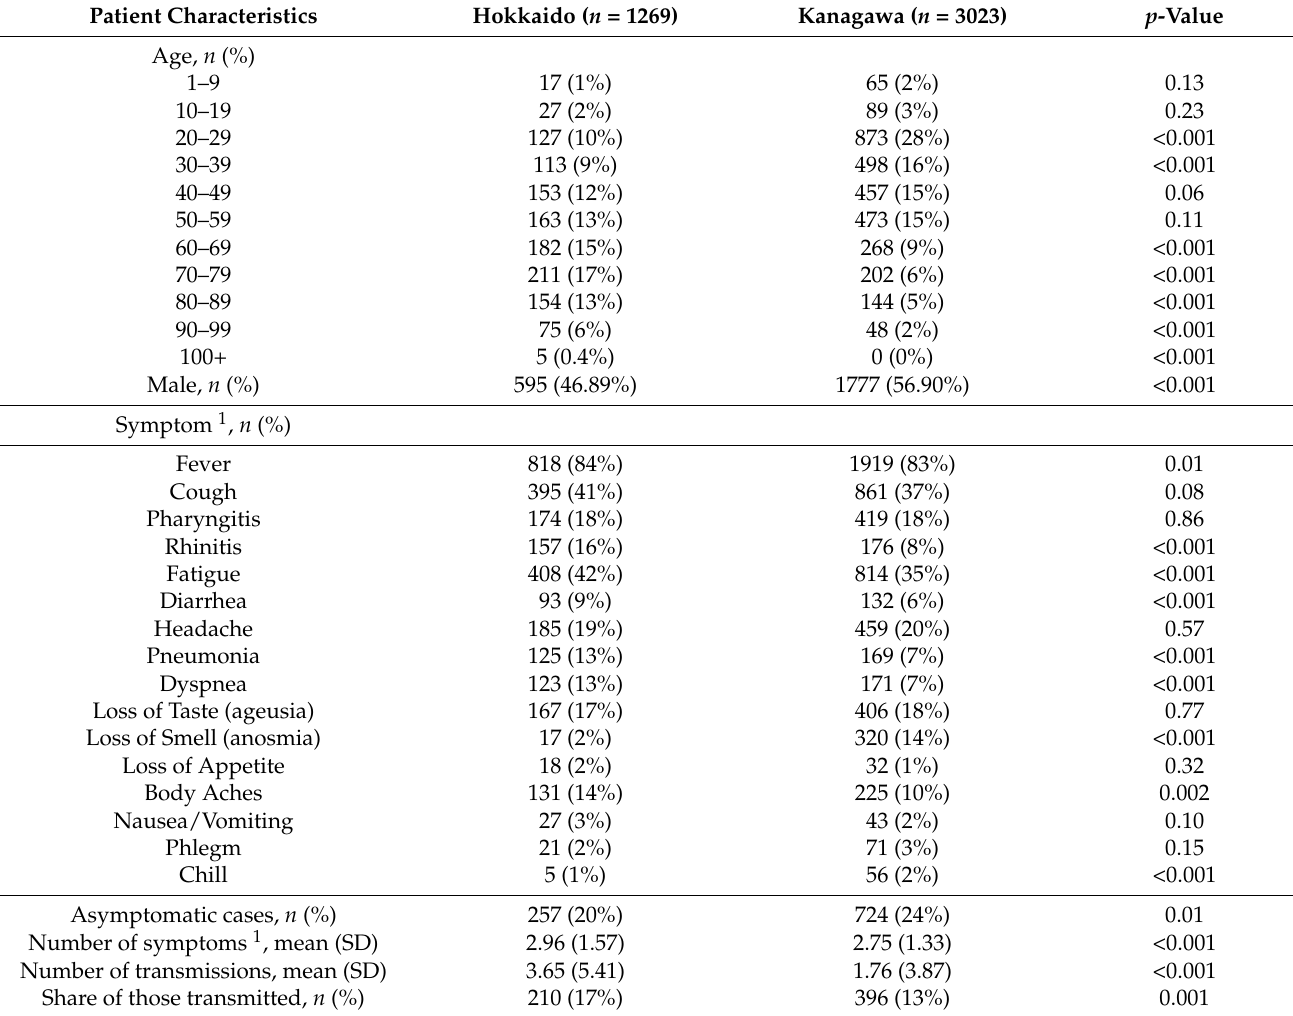
Table 2. COVID-19 Patient Characteristics by